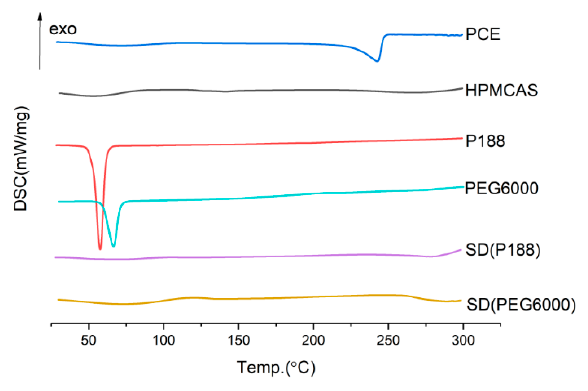
Figure 3. DSC diagram of solid dispersion prepared by different plasticizer.